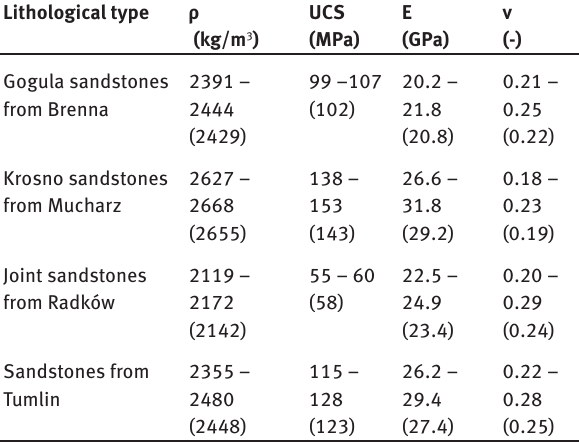
Table 1: Range of results of geomechanical laboratory tests (mean values in